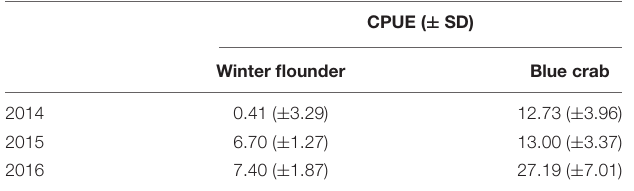
TABLE 5 | Catch per unit effort (CPUE, number of individuals per hour trawled) for winter flounder ( Pseudopleuronectes americanus ) and blue crab ( Callinectes sapidus ) of the selected sizes for summer flounder predation ( < 100 mm) in Shinnecock Bay (SD = standard deviation).